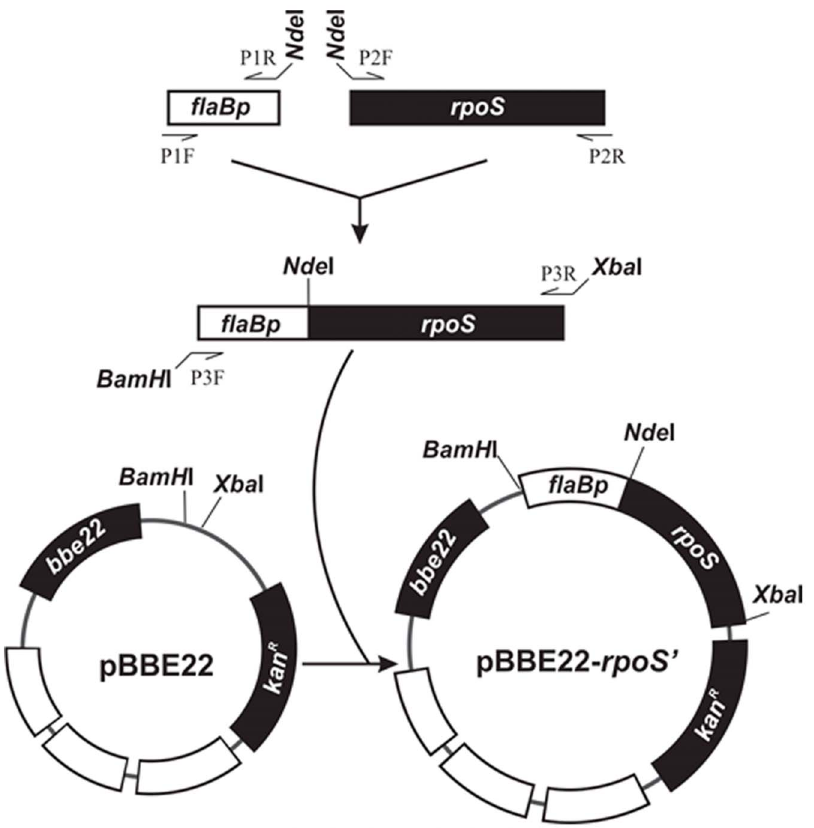
Figure 1. Construction of pBBE22- rpoS’ . The flaB promoter region ( flaBp ) and the promoterless rpoS gene were PCR amplified, fused, and cloned into pBBE22. doi:10.1371/journal.pone.0083276.g001 template and amplified with the use of a primer pair, P3F and P3R. The amplicon was purified, digested with BamHI and XbaI, and cloned into pBBE22 (a gift from S. Norris) [25]. The insert and flanking regions within the recombinant plasmid were sequenced to ensure the construct was as designed.